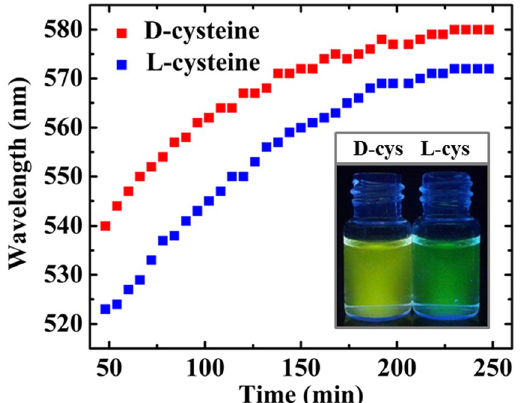
Figure 4. Changes in the wavelength of maximum fluorescence after the addition of D- and L-cysteine (2 mmol L − 1 ) against time (min). The inset shows fluorescence images of QDs 2 h after the addition of